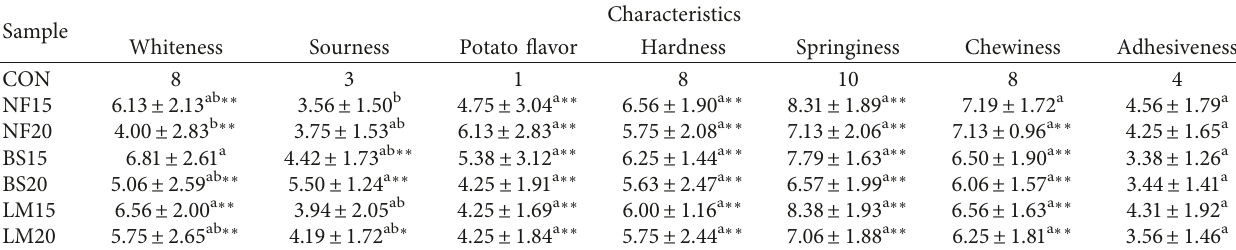
Table 3: Quantitative descriptive analysis scores of potato garaetteoks Sample